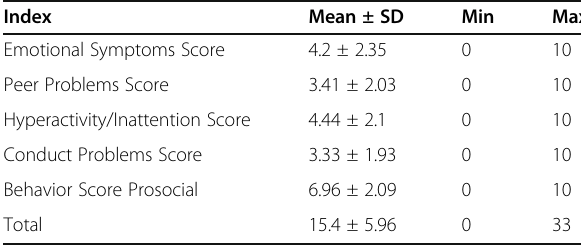
Table 1 Mean and standard deviation of the index of emotional and behavioral problems questionnaire in